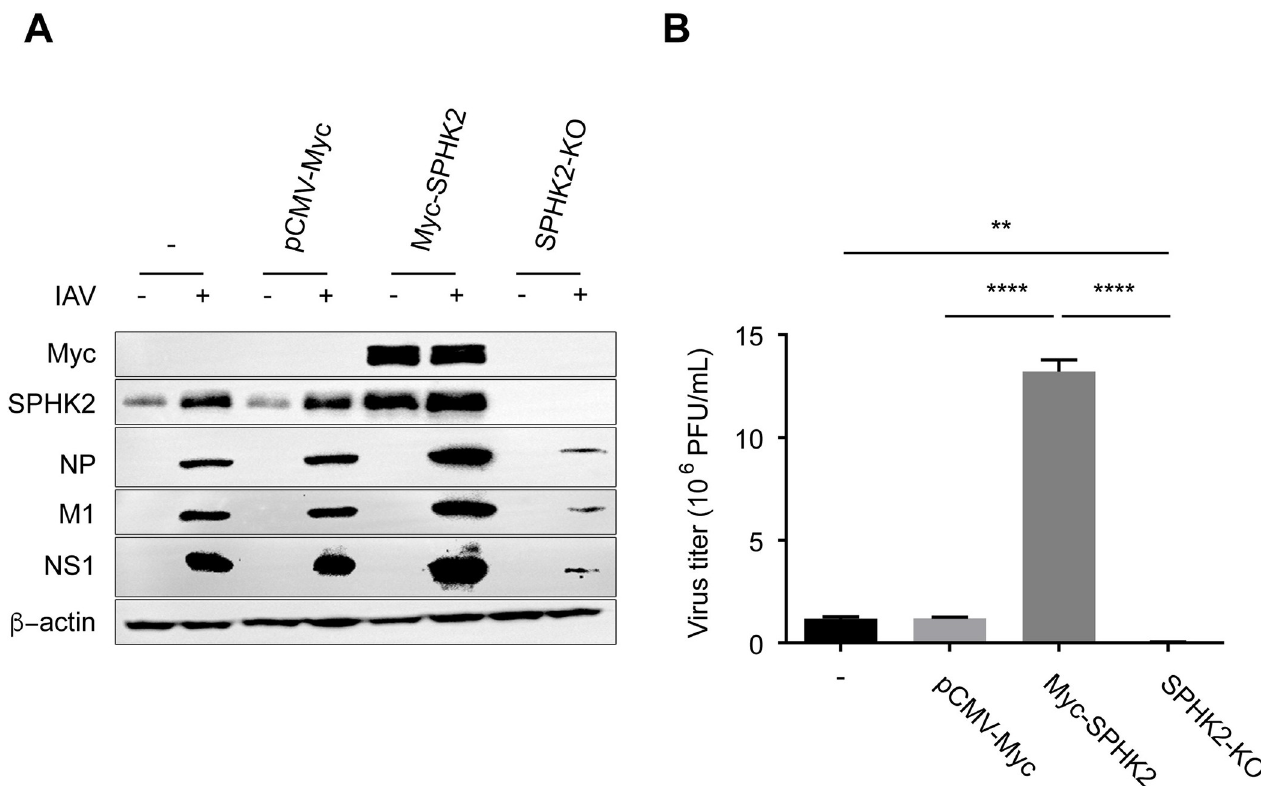
Fig 3. SPHK2 facilitates IAV replication. ( A ) A549 cells were transfected with plasmids encoding SPHK2 or a control vector pCMV-Myc, and 24 h after transfection, cells were infected with WSN virus at an MOI of 0.5. A549 cells or sgSPHK2-1 A549 cells were infected with WSN virus at an MOI of 0.5. At 24 hpi, Western blotting analysis was performed to detect viral NP, M1, NS1 and β -actin is shown as a loading control. ( B ) Virus titers in IAV (MOI = 0.5) infected A549 cells transfected with the plasmids pCMV-myc or Myc-SPHK2 and virus titers in IAV infected A549 cells or IAV infected sgSPHK2-1 A549 cells was determined in MDCK cells by plaque assay. Values are means ± SD (n = 3). Data are representative of three independent experiments. �� , P < 0.01; ���� , P <